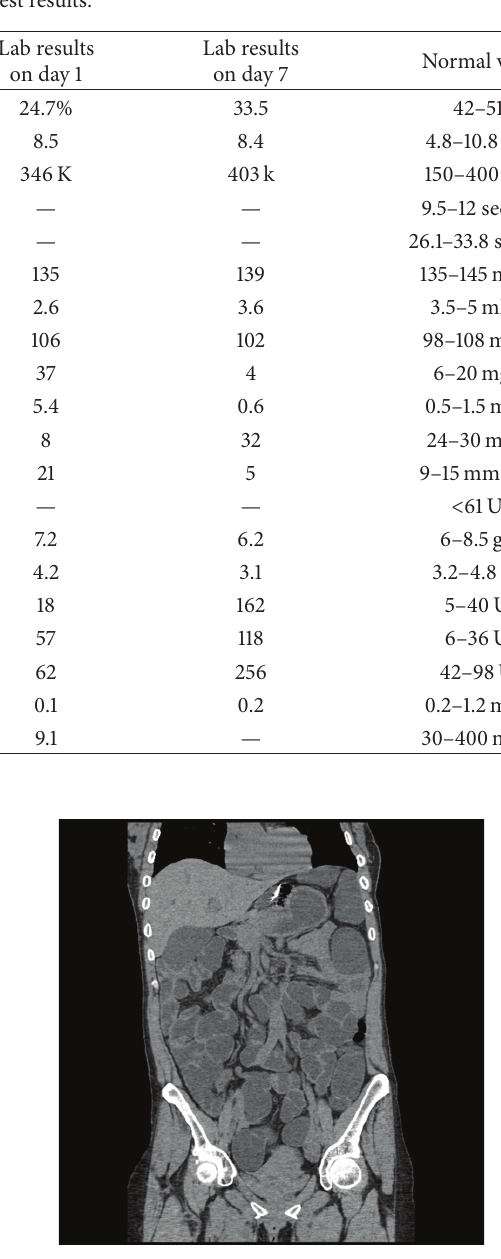
Figure 1: Computed tomography abdomen image showing nondi- lated bowel